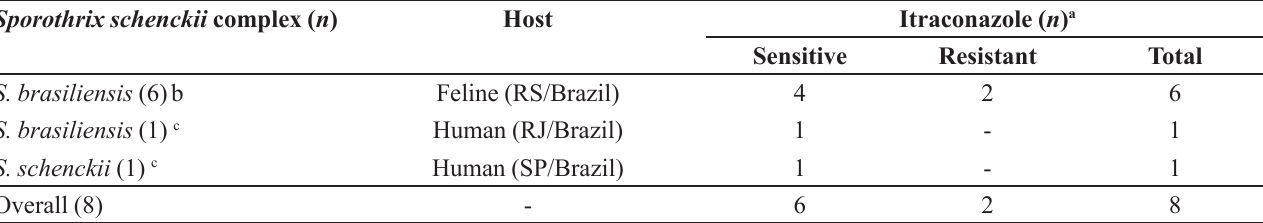
TABLE II - Susceptibility of Sporothrix schenckii complex isolates to itraconazole (µg/mL) Sporothrix schenckii complex ( n